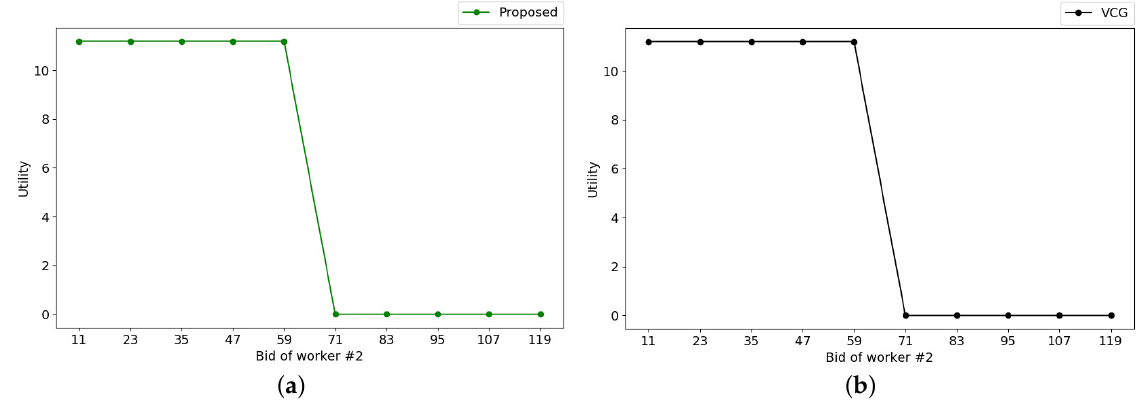
Figure 11. Truthfulness of both mechanisms. ( a ) proposed mechanism; ( b ) VCG